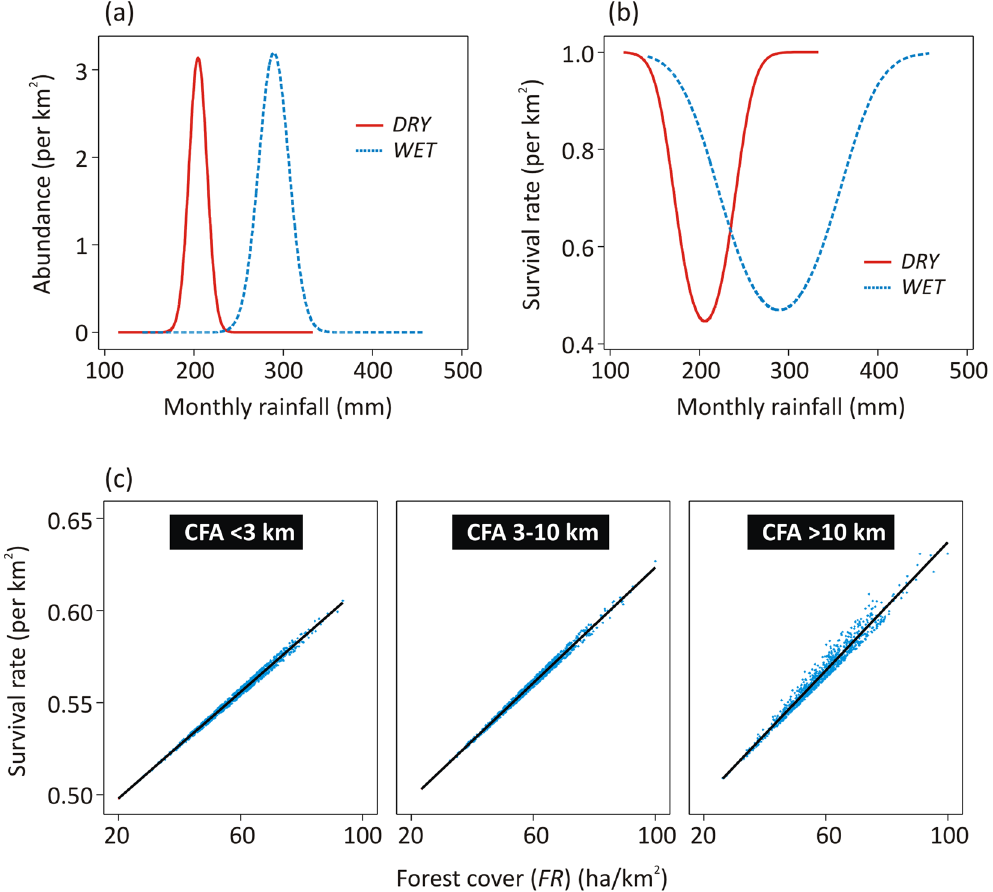
Figure 3. The effect of seasonal rainfall, forest cover, and distance to forest recently converted to industrial agriculture, on the orangutan abundance and survival rates. The relationship between the monthly mean rainfall during the dry season ( DRY ) and wet season ( WET ) on the orangutan abundance in the initial time period 1997–2002 ( a ) and the survival rate every six years between 1997 and 2015 ( b ). The effect of forest cover ( FR ) on orangutan survival rate, with varying distances to forest recently converted to industrial agriculture ( CFA ) ( c